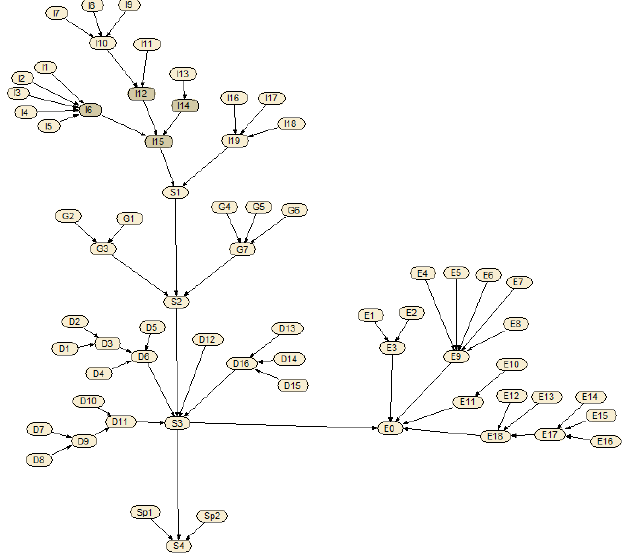
Figure 3. The Bayesian network structure for fire risk assessment with the software of Netica.